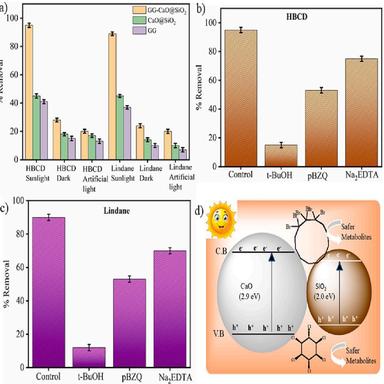
(a) Percentage removal of HBCD and Lindane under sunlight, artificial bulb light and dark conditions. (b–c) Corresponding bar diagram is showing the percentage removal of HBCD and Lindane degradation under sunlight in presence of radical scavengers (d) Reaction mechanism followed by nanocomposite for the degradation of HBCD and Lindane under sunlight.